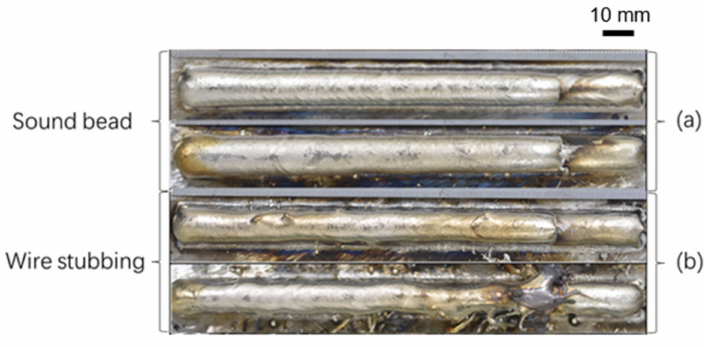
Figure 6. Typical bead appearances. ( a ) Sound bead and ( b ) wire